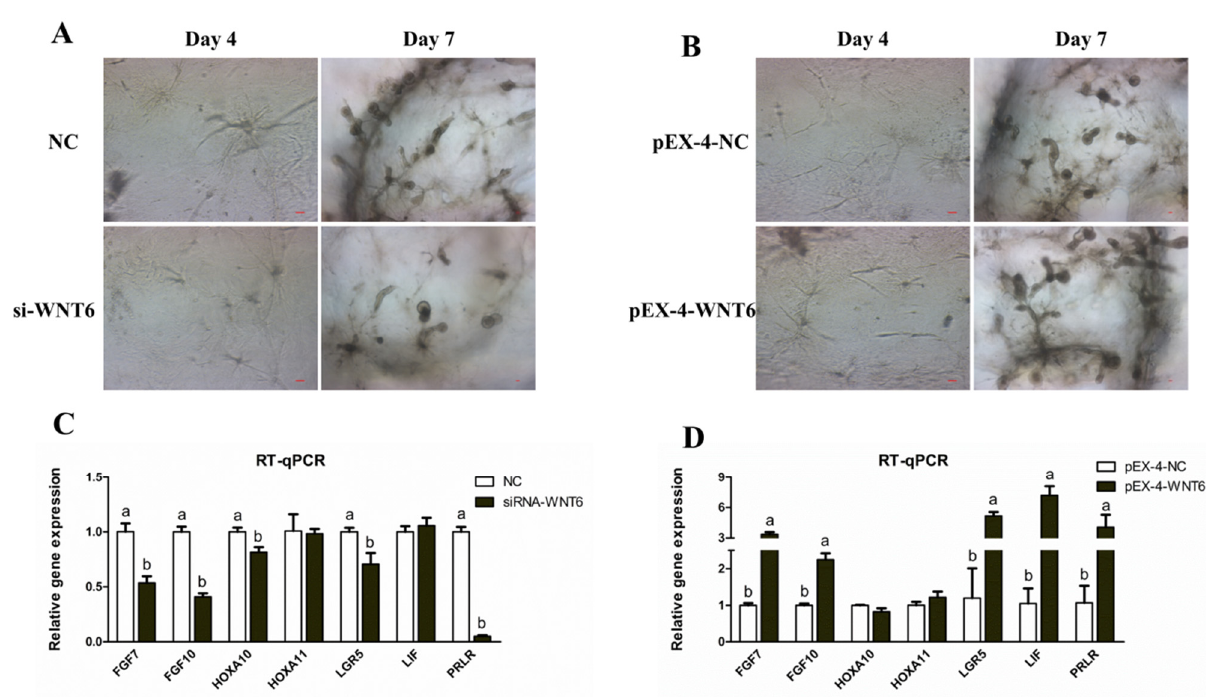
Figure 6. Effects of WNT6 transfection on the development of ovine UGs organoid. ( A ) Effects of WNT6 suppression (si-WNT6) on organoid development. ( B ) Effects of WNT6 overexpression (pEX-4-WNT6) on organoid development. ( C ) The expression of glandular development related genes in UGs organoid by WNT6 suppression. ( D ) The expression of glandular development related genes in UGs organoid by WNT6 overexpression. NC, Negative control was the siRNA with scrambled sequence absent in the sheep genome. si-WNT6, the small interfering RNA for WNT6 . pEX-4-NC, Negative control of pEX-4 was the empty vector. pEX-4-WNT6, pEX-4 vector with WNT6 -CDs inserted. Values are presented as the mean ± SDs. Means with different letters indicate significant differences ( p < 0.05). Bar = 50 μ m.